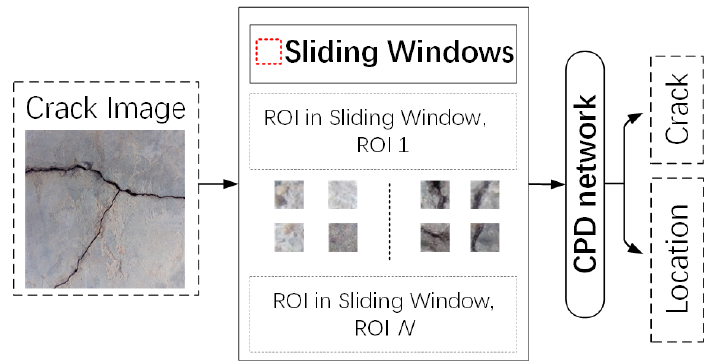
Figure 8. Schematic diagram of the procedure of crack position detection using a sliding window.